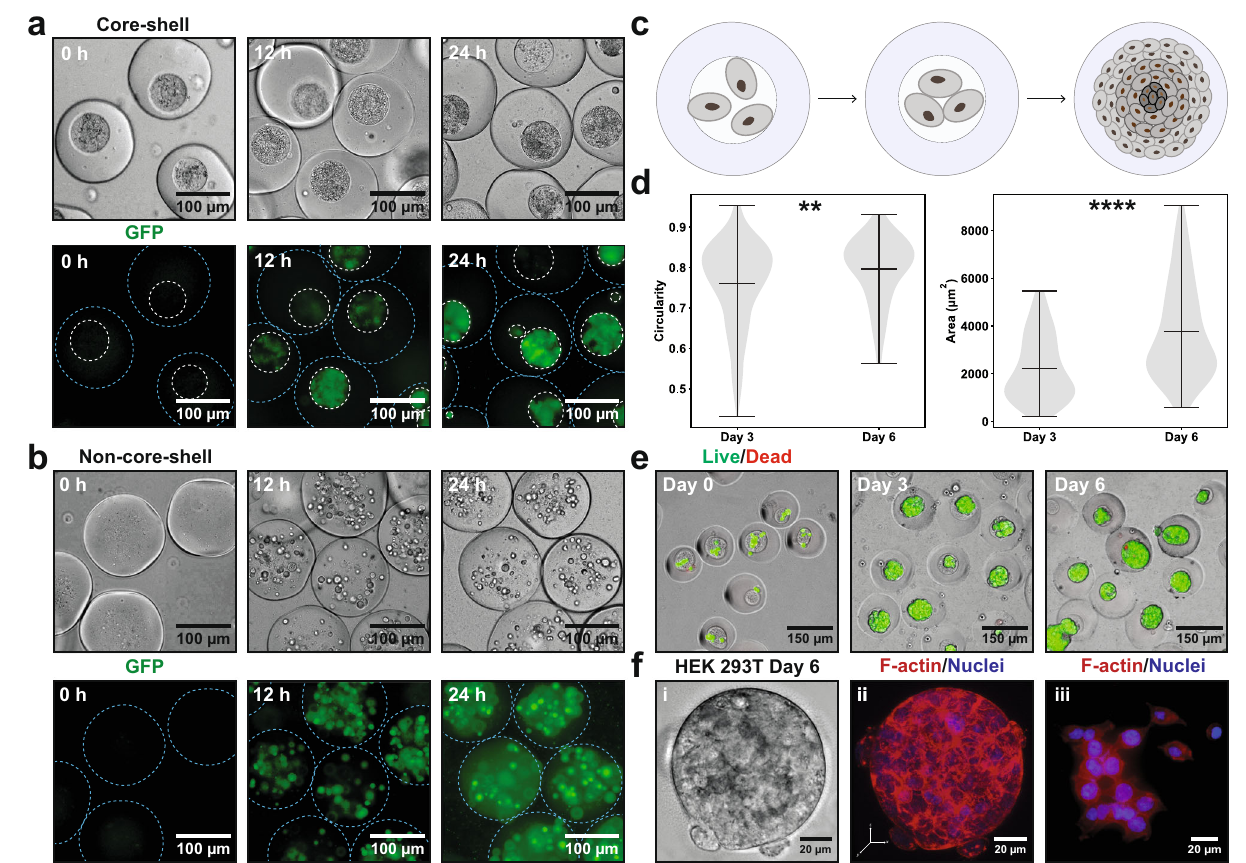
Fig. 3 | Core-shell microgels for cell culture. Left panel: GFP Escherichia Coli ( E. coli .) in core-shell and non-core-shell microgels. Right panel: formation and char- acterization of HEK 293T cellular spheroids in core-shell microgels. a Proliferation of GFP E.coli .inthecore-shellmicrogels.Cellgrowthiscon fi nedinside theviscous microgel cores. b Proliferation of E. coli . in the non-core-shell microgels. E. coli proliferate locally to form visible microcolonies. Blue and white dashed lines out- line the microgels and the CMC cores, respectively. c Schematic representation of the formation of multicellular spheroids. Due to spatial con fi nement, cells are allowedtointeractinallthreedimensionstoformmulticellularspheroidsfeaturing a hierarchical structure. d Growth of HEK 293T spheroids from day 3 to day 6, quanti fi ed by spheroid circularity and area. Data are represented as mean values